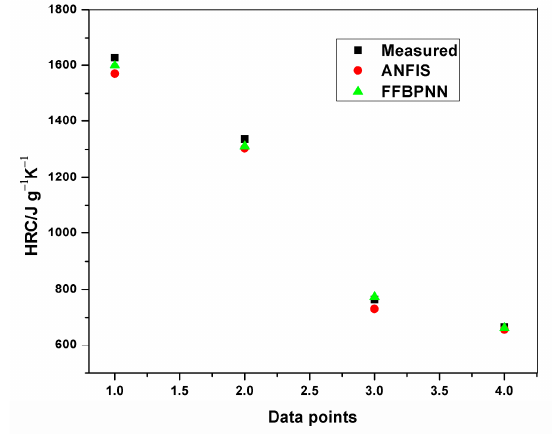
Figure 12. Comparison of HRC training results.